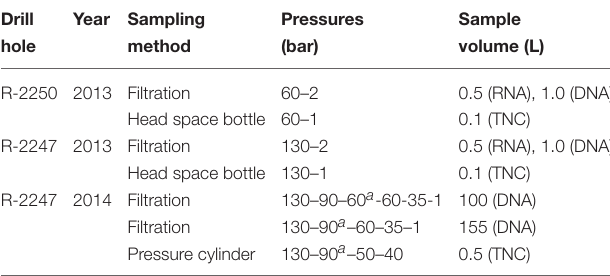
TABLE 1 | Collected microbial groundwater samples from two drill holes: Sampling methods, measured pressures during sampling, and sample